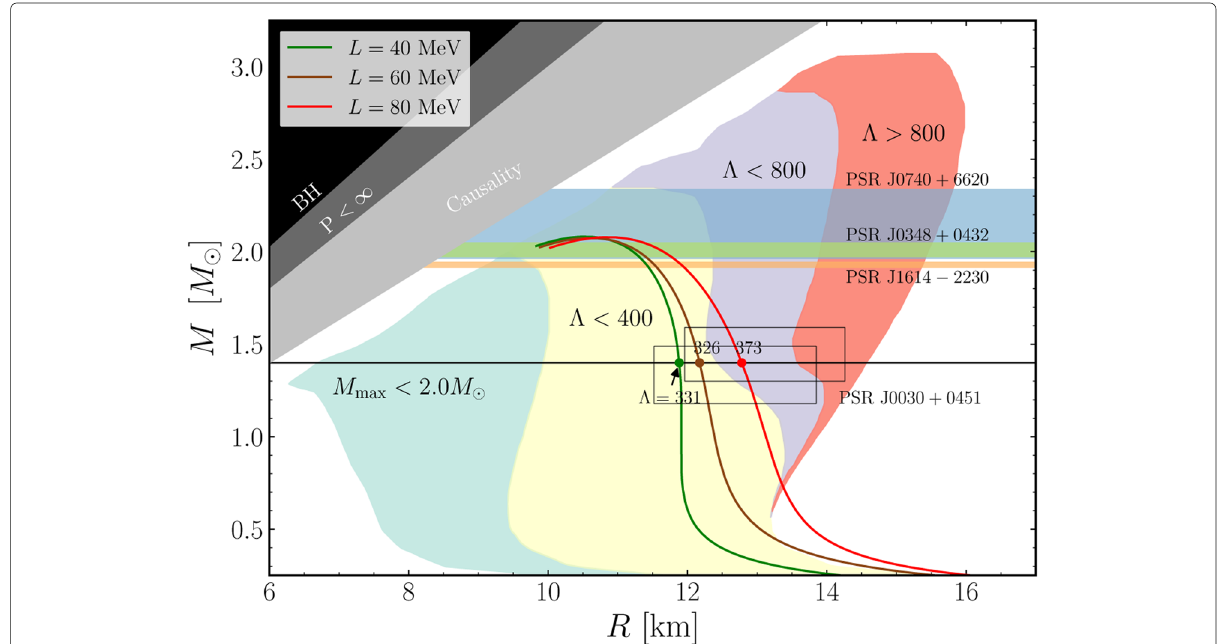
Fig. 5 NS mass-radius relation with different values of symmetry energy slope L and the observational constrains from the GW170718 NSM event and other NSs. Find detailed explanations in Ref.